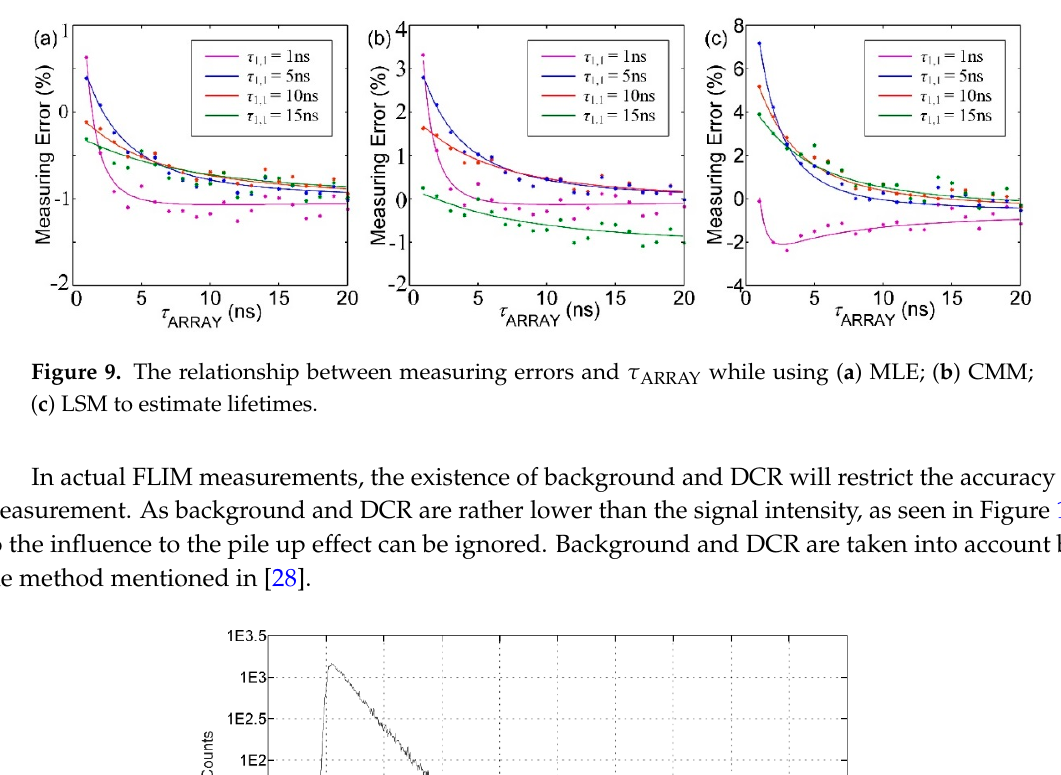
( b ) Figure 11. The process corner simulation result of the quenching circuit: ( a ) t width ; ( b ) t delay .